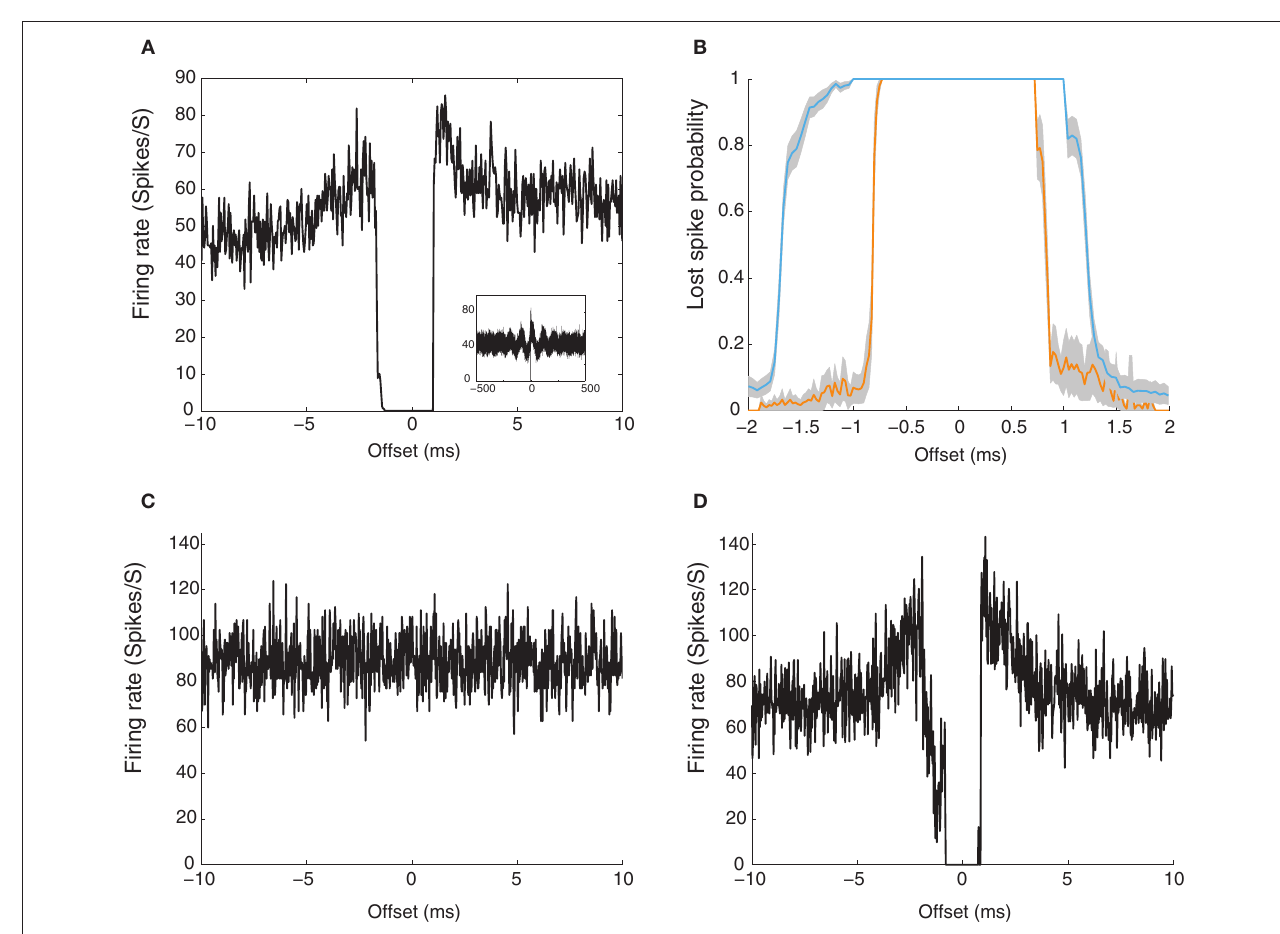
the close pairs sorted offline (monkey Cu, n = 24 pairs, in blue) and online (monkey S, n = 15 pairs, in orange). Gray shading marks the SEM. The shadowing effect for the online sorting is shorter than that of the offline sorting. (C) Example of cross correlation of a pallidal remote pair (i.e., recorded by different electrodes) from monkey S. (D) Cross correlation of the pair shown in (C) , after artificial shadowing by one of the five representative